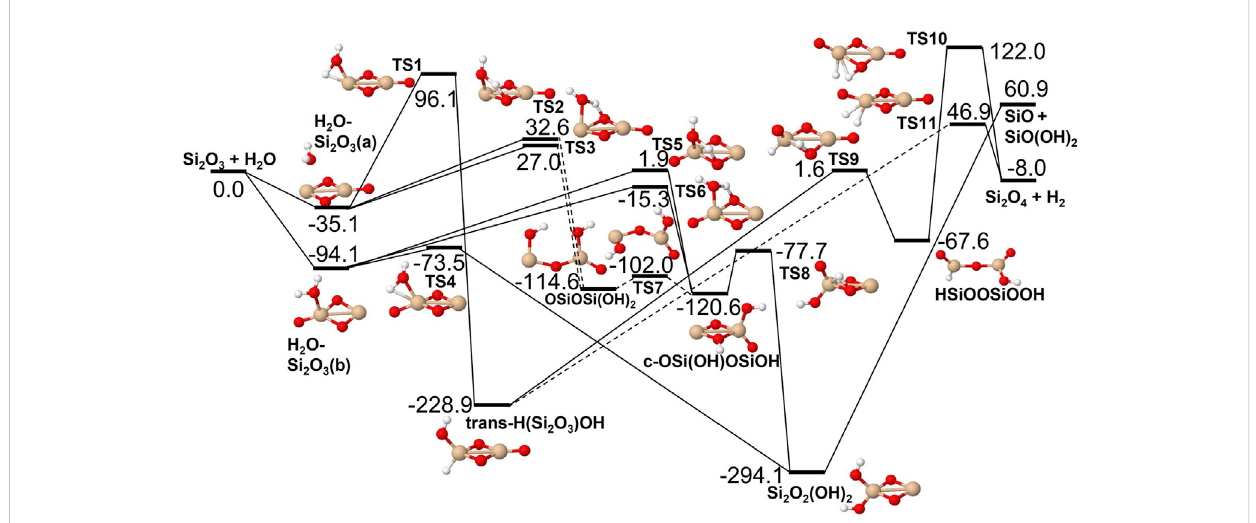
FIGURE 5 PotentialenergysurfacebasedonM06calculationsfortheSi 2 O 3 +H 2 OreactionasimplementedintheRRKMcalculations.Theenergiesaregivenin kJ/mol and include zero-point energy corrections. Dashed lines indicate that the reaction step has been simpli fi ed by combining several similar intermediate isomers.